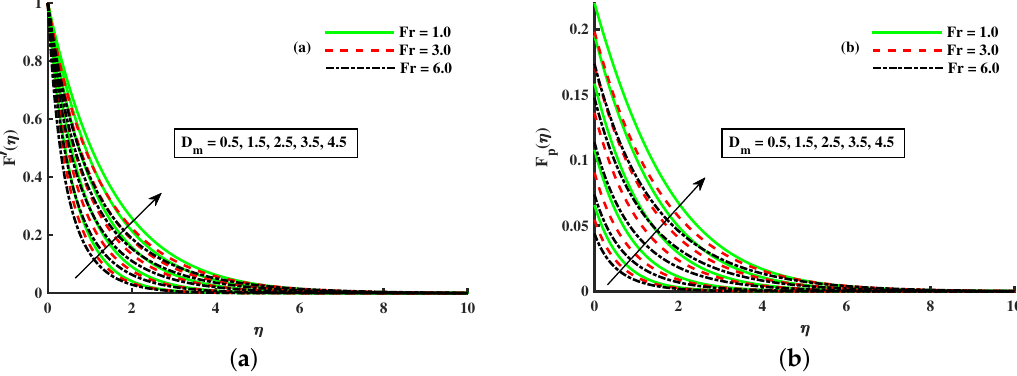
Figure 11. Fluctuation of Fr and D m on F (cid:48) ( η ) ( a ) and the effect of Fr and D m on F p ( η ) ( b